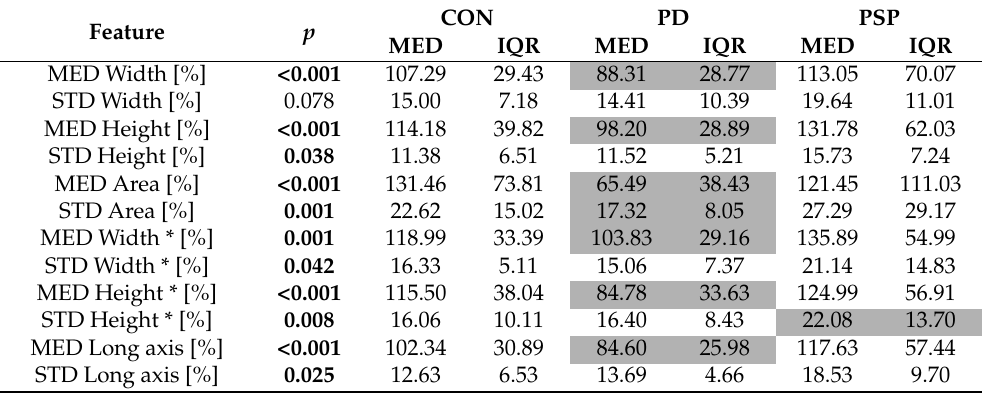
Table A3. Results of the Kruskal–Wallis ANOVA for rectangles. Statistically significant values in bold ( p < 0.05). Groups with mean ranks significantly different from others are marked in gray. MED and STD by the feature name denote median and standard deviations for all triangles/rectangles in the patient’s sequence. Features extracted after rotation (see definition) are marked with